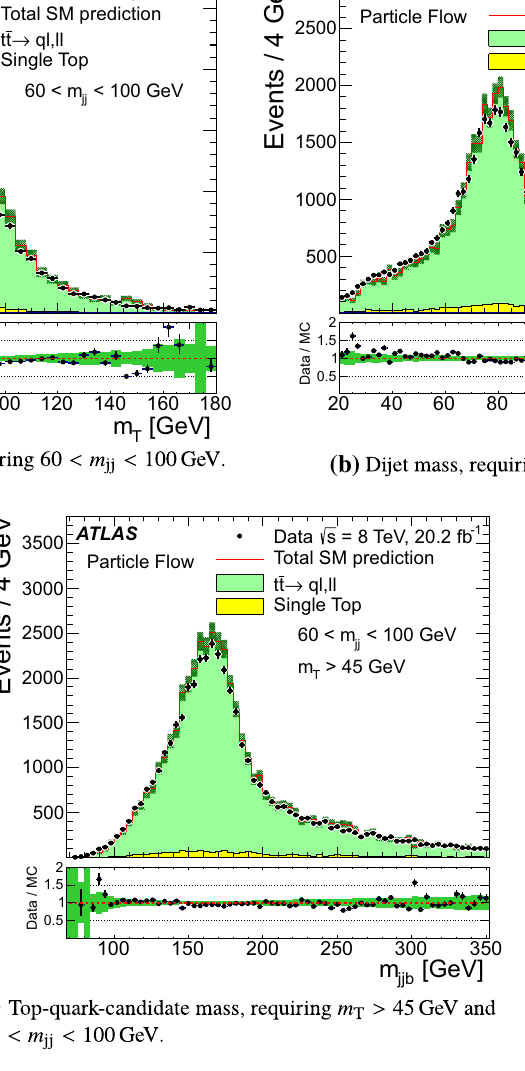
Fig. 36 Comparison of the distributions of mass variables computed with particle flow jets between collision data and the MC simulation for a t ¯ t event selection. The darker shaded bands and the errors on the collision data show the statistical